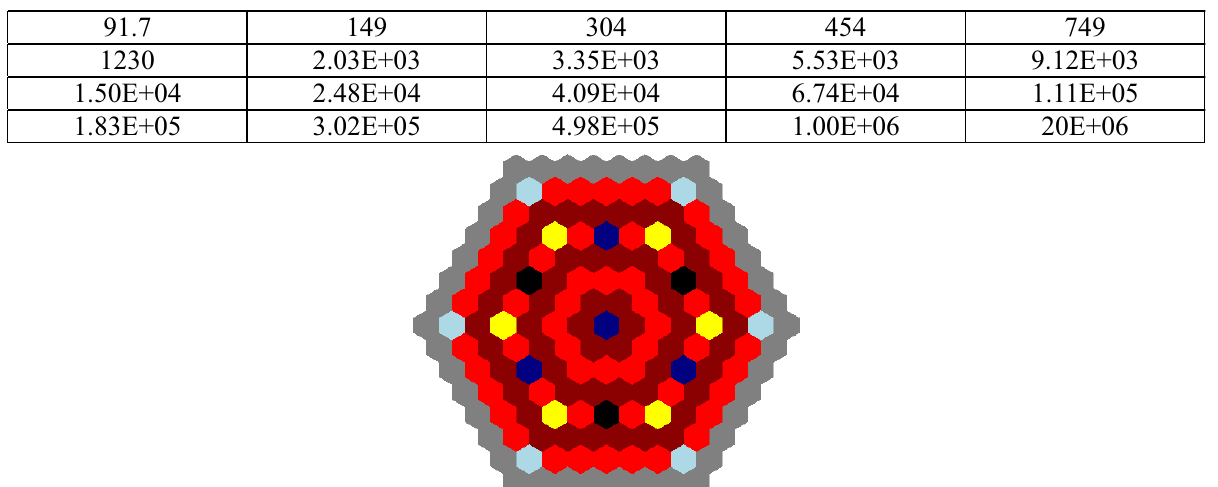
Table I. Energy-mesh (eV): Group cross-sections